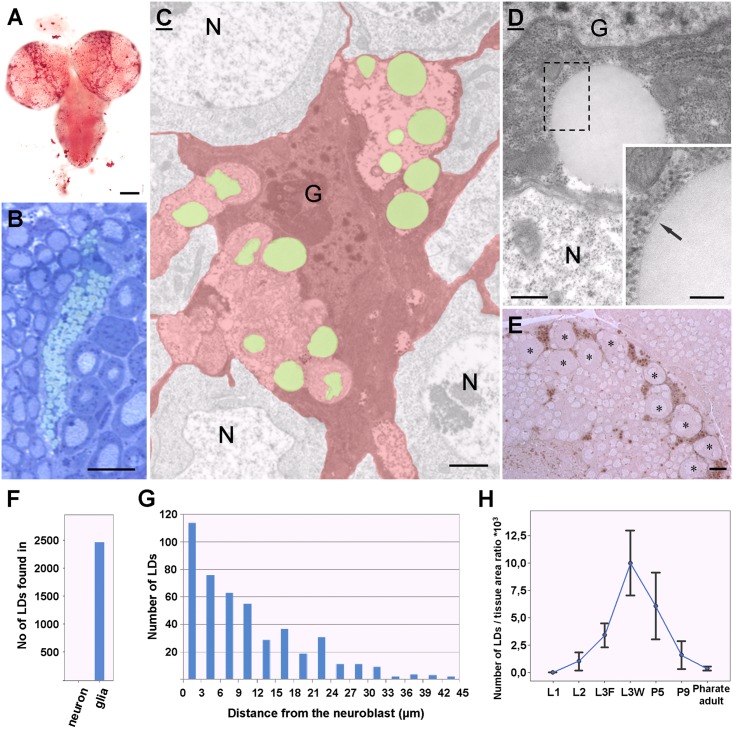
Lipid droplets in the Drosophila brain.(A-E) Pictures taken from third instar larval brains. (A) Oil Red O staining, note an intense staining in the dorso-medial part of the central brain. (B) Toluidine blue-stained semithin section from the brain cortex. LDs (green) are organized in large clusters between neurons. (C) Pseudocolored electron micrograph taken from the brain cortex. LDs (green) are found in the cytoplasm of glial cells (G, red) but not in neurons (N). (D) High power electron micrograph from the perinuclear region of a cortex glia (G) LDs are rounded electron-opaque structures, delineated by a phospholipid monolayer (inset, arrow). N: neuron. (E) LDs (brown) are generally found in the closest vicinity of neuroblasts (asterisks). Unstained semithin section. (F) Diagram representing the distribution of LDs between neurons and glial cells. (G) Number of LDs in order of their distance from neuroblasts. (H) Time-course changes in the amount of accumulated LDs per brain tissue area ratio. Standard deviations are indicated. Scalebars: (A) 100 μm (B) 10 μm (C) 1μm, (D) 500nm, inset: 200nm, (E) 10 μm.